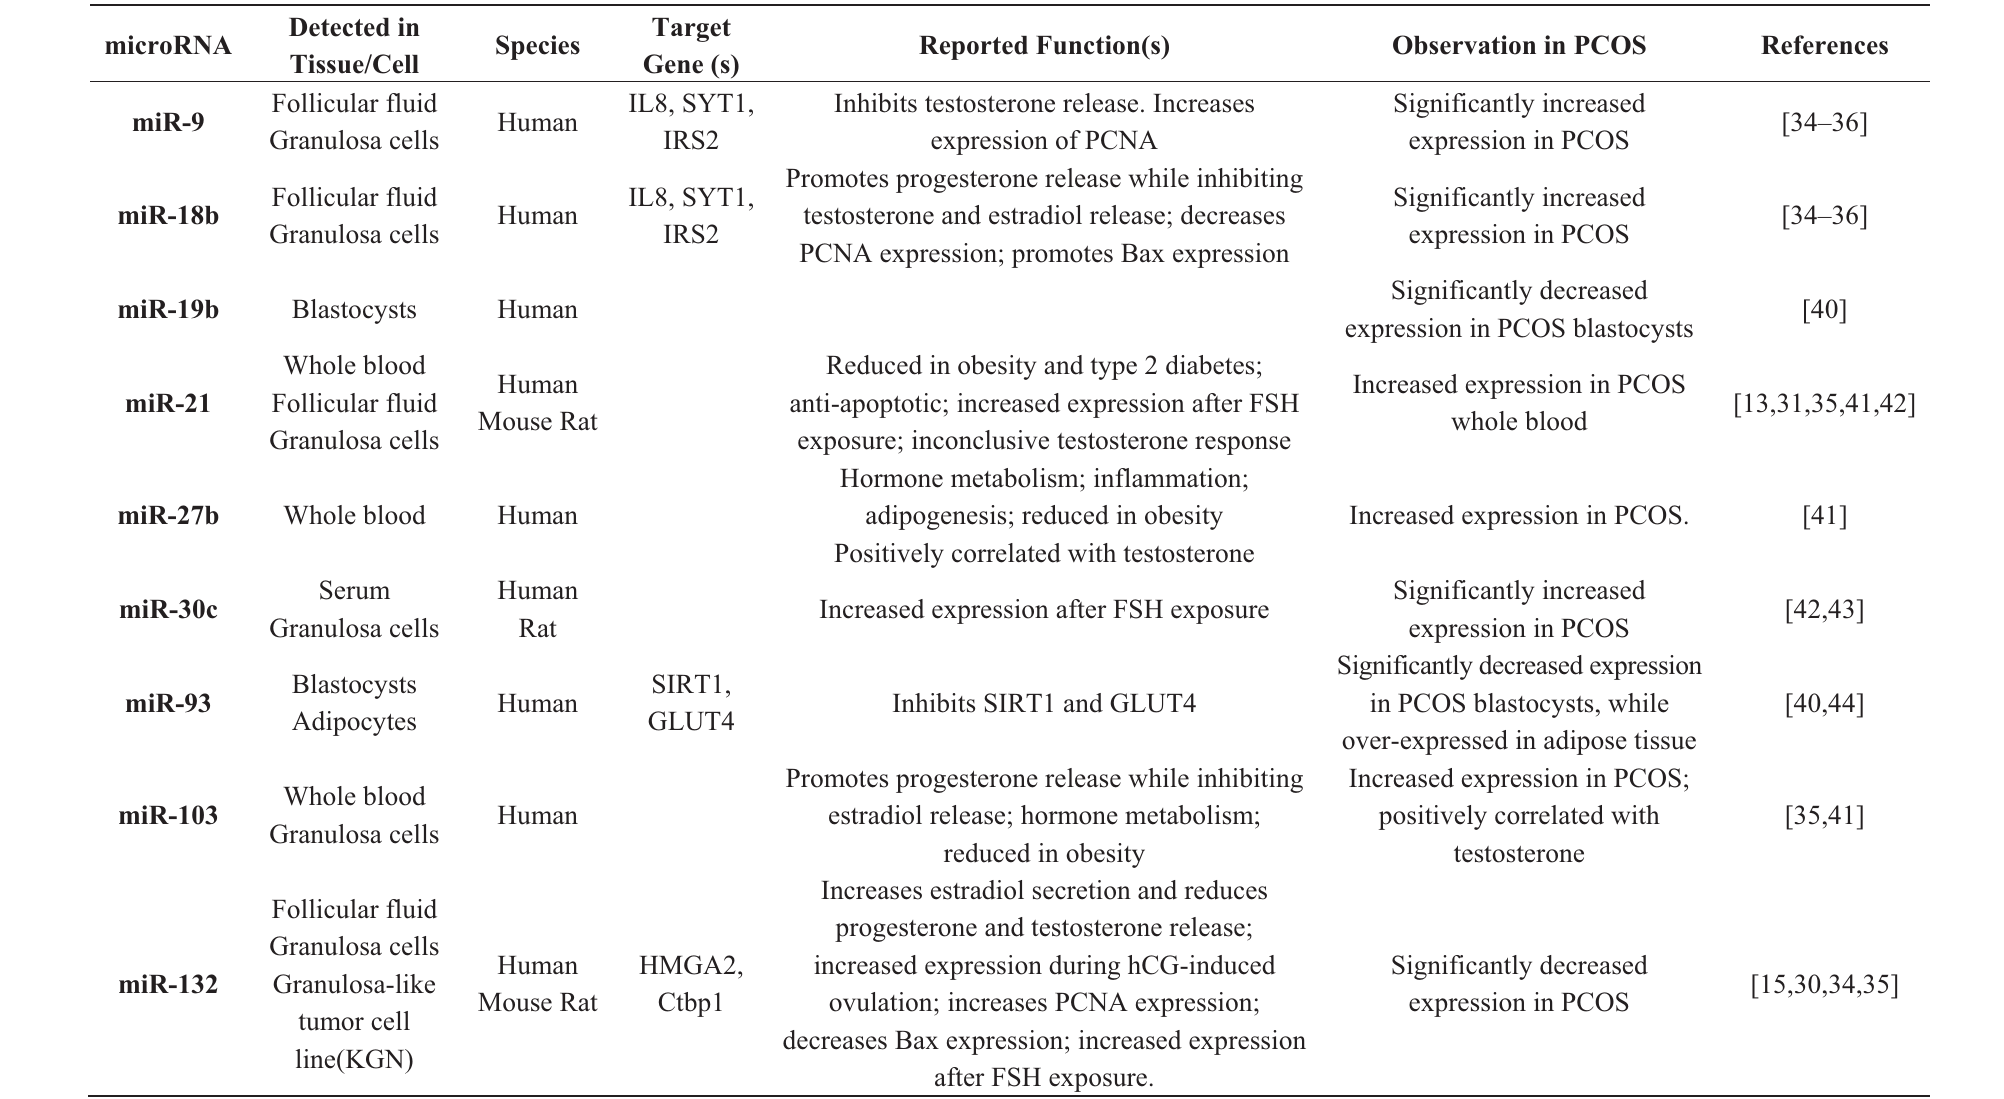
Table 1. List of microRNAs observed in polycystic ovary syndrome (PCOS), their proposed functions and